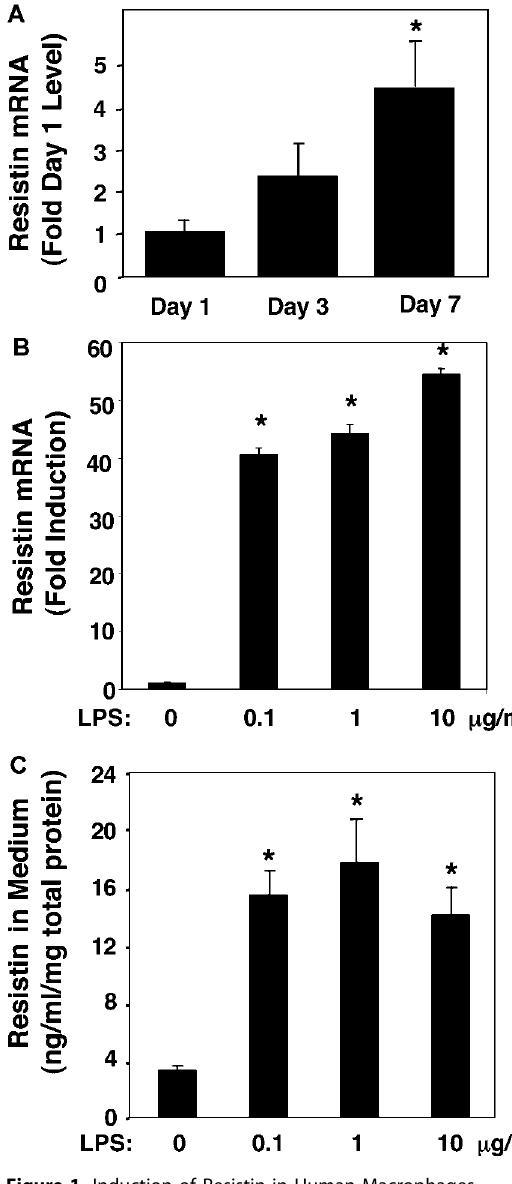
Figure 1. Induction of Resistin in Human